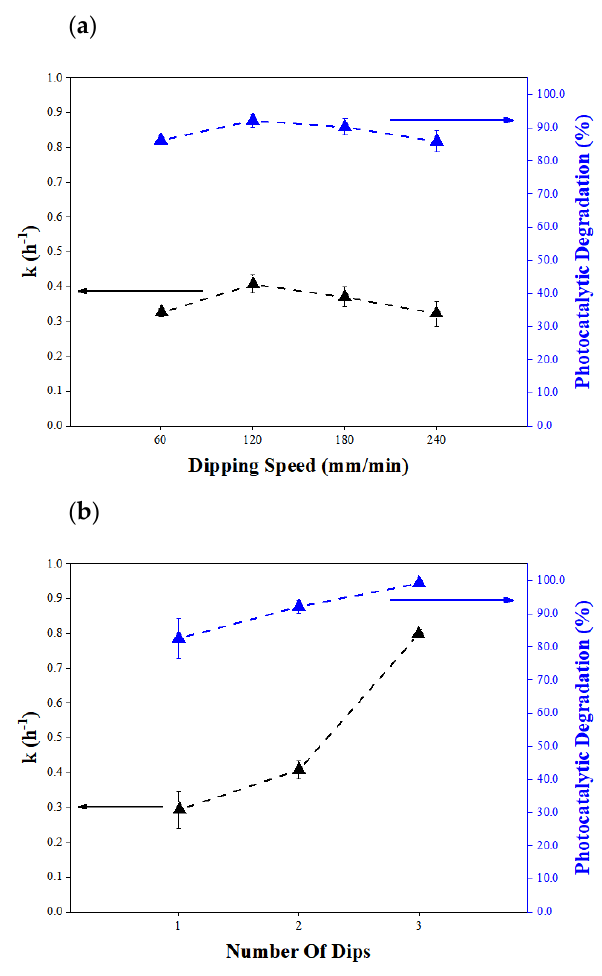
Figure 5. ( a ) Effect of dipping speed on photocatalysis kinetics and degradation percentage; ( b ) effect of number of dips on photocatalysis kinetics and degradation percentage.